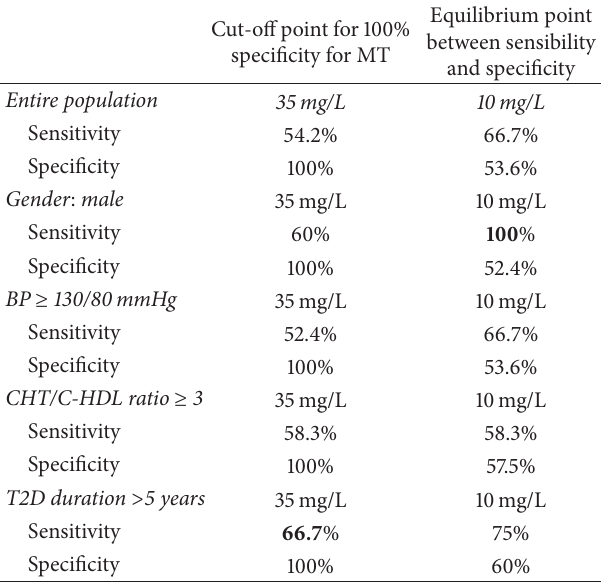
Table 2: Sensitivity and specificity among subgroups depending on the chosen